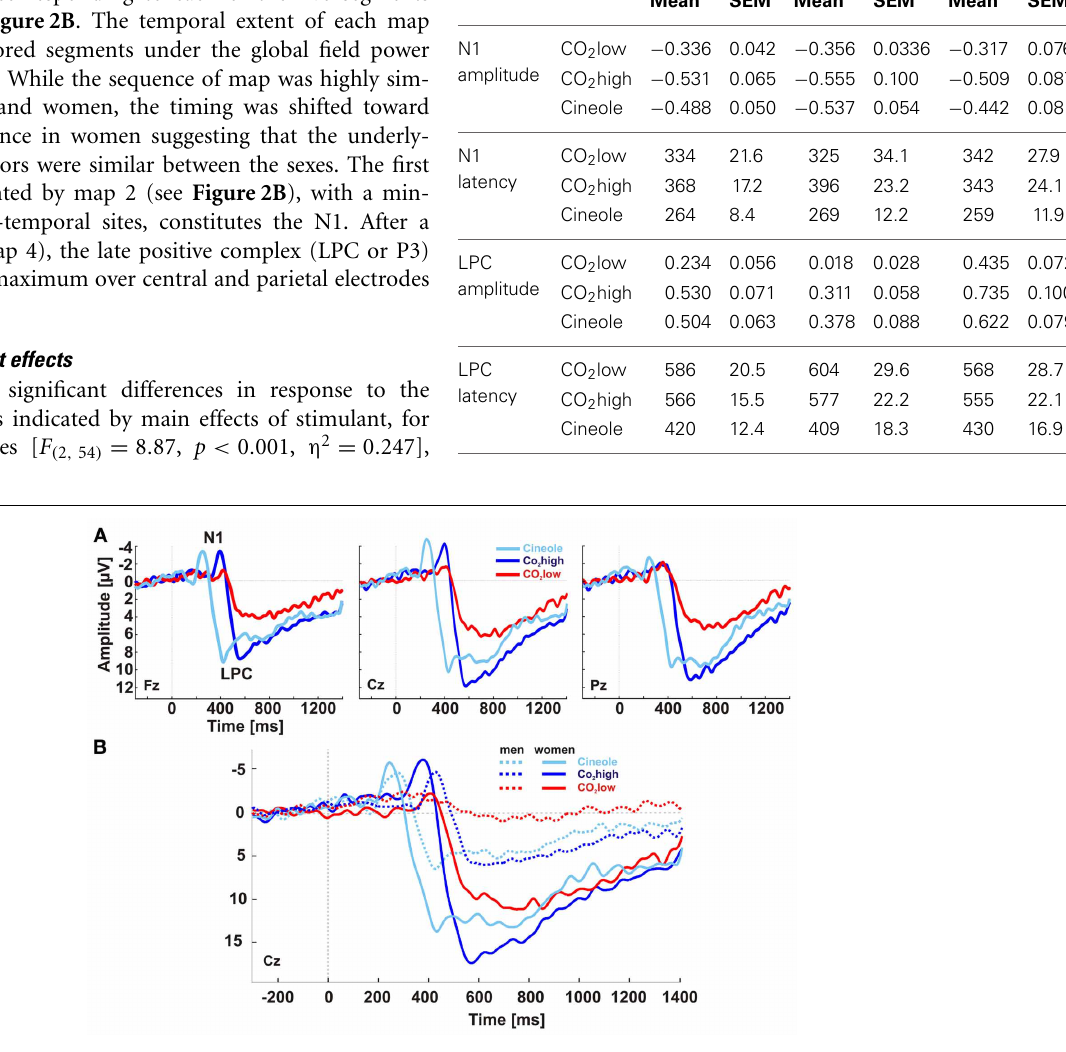
FIGURE 1 | Baseline-corrected, grand-averaged ERPs at electrodes Fz, Cz, and Pz yielded two major ERP deflections for all stimulants: an early negative peak (N1) and a late slow positive peak (LPC) (A). Women exhibited overall shorter latencies and larger amplitudes than men (B) .